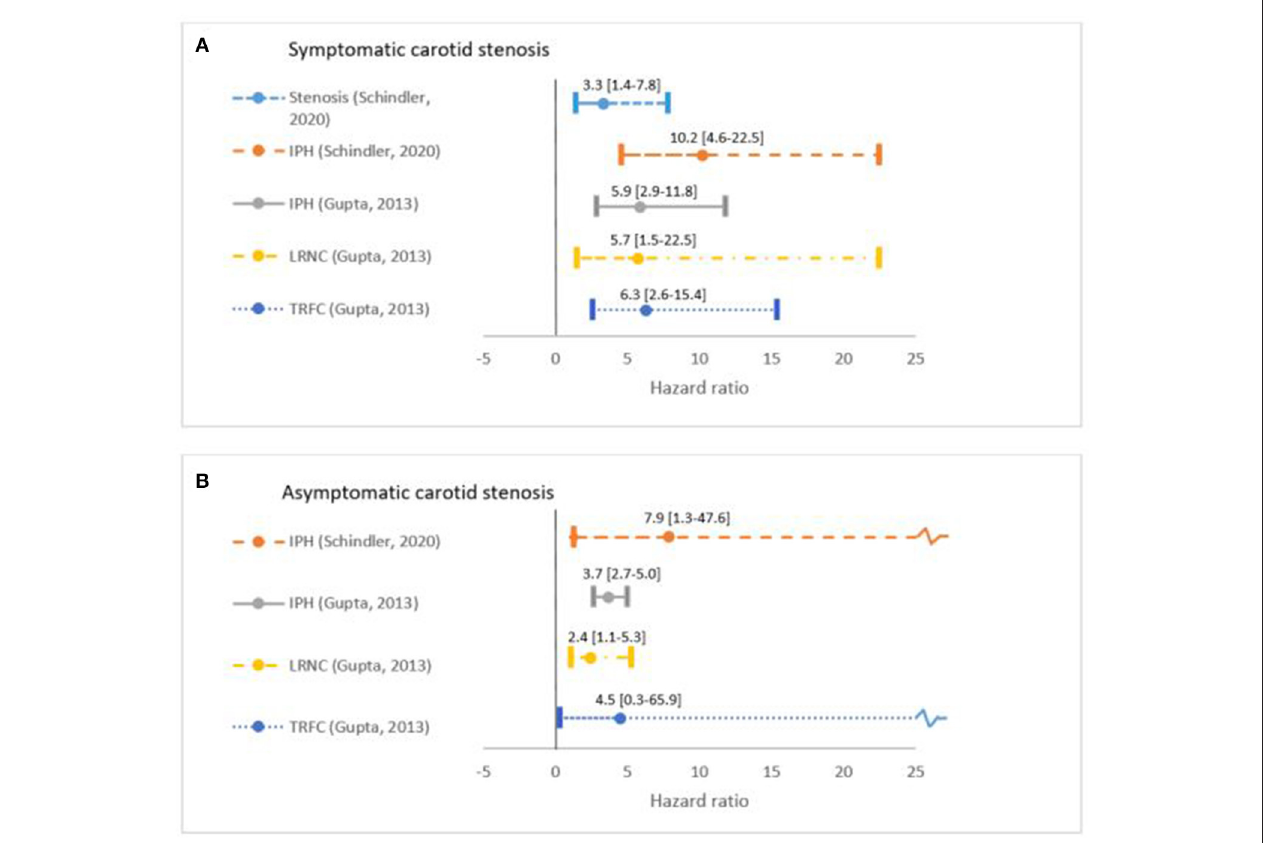
FIGURE 2 | Overview of predictive value in Hazard Ratio [95% confidence interval] of plaque vulnerable features as reported in two meta-analyses. Schindler et al. (24) included 560 symptomatic and 136 asymptomatic participants with 66 ipsilateral ischemic strokes gathered from seven studies. The meta-analysis by Gupta et al. (37) consists of in total 779 patients (ratio symptomatic and asymptomatic unclear) with at least 169 ipsilateral ischemic strokes and TIAs (exact number unclear). Plaque volume is not included in this overview due to the lack of reported predictive value in meta-analyses. Patients are grouped into (A) symptomatic and (B) asymptomatic when data was available and hazard ratios were reported for the degree of stenosis, intraplaque hemorrhage (IPH), thin or ruptured fibrous cap (TRFC), and lipid-rich necrotic core (LRNC). Hazard ratios reported in Gupta et al. (37) include both ischemic stroke and TIA, while Schindler provided ischemic stroke hazard